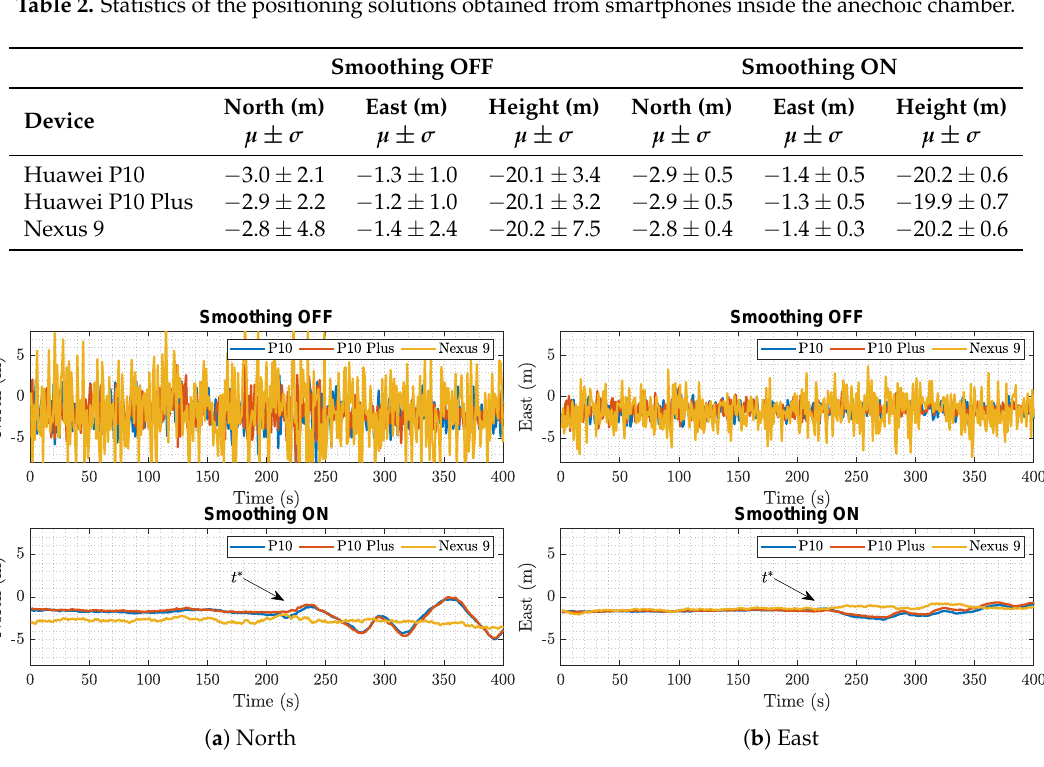
Table 2. Statistics of the positioning solutions obtained from smartphones inside the anechoic chamber.